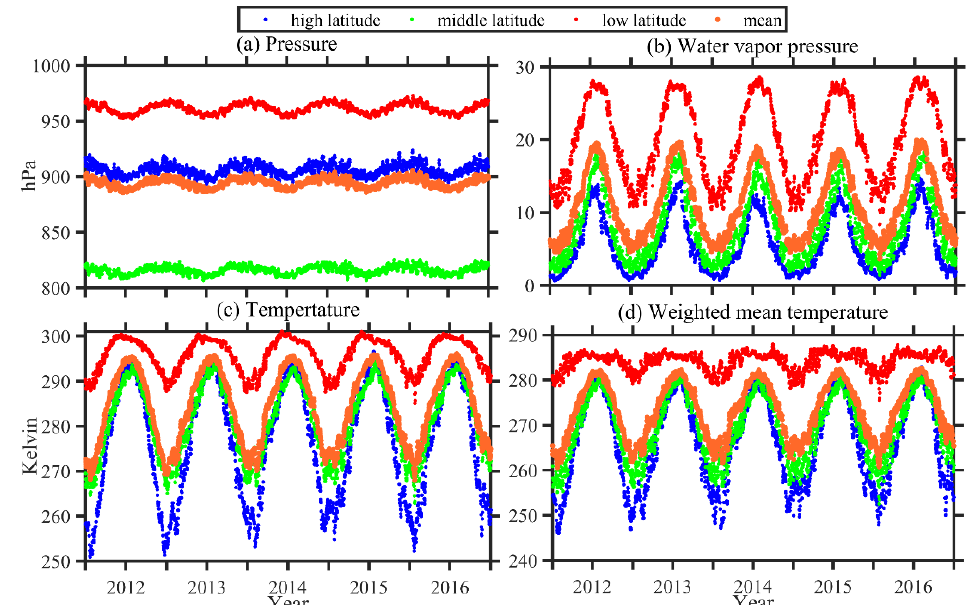
Figure 3. Time series of tropospheric parameters for pressure ( a ), parameters for water vapor pressure ( b ), parameters for temperature ( c ), and parameters for T m ( d ) provided by MERRA-2 data from 2012 to 2016. The dots shown are the mean values of each latitude interval for each epoch. Blue dots are at high latitude, green dots are at middle latitude, red dots are at low latitude, and orange dots are the mean value.